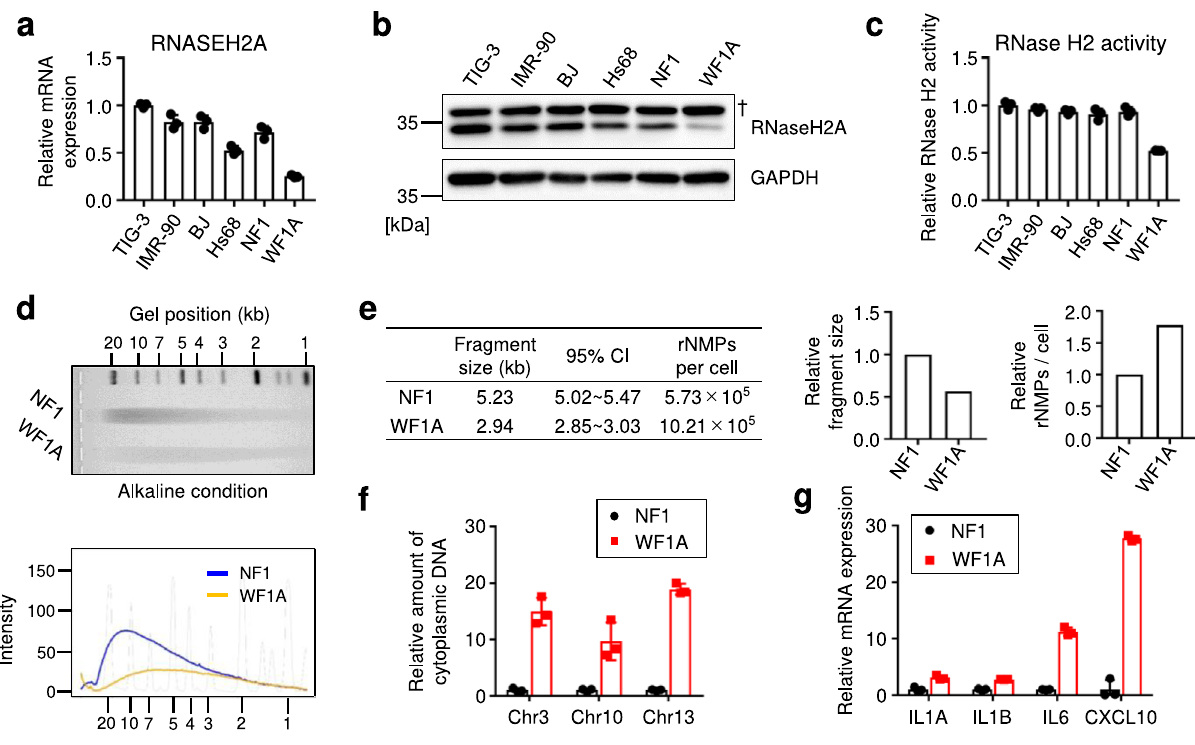
Fig. 6 RNaseH2A dysfunction also occurs in cells derived from patients with Werner syndrome. a RT-qPCR analysis of RNASEH2A mRNA expression in TIG-3, IMR-90, BJ, Hs68, NF1 and WF1A cells (35-40 population doublings). NF1: healthy human fi broblasts, WF1A: fi broblasts derived from patients with Werner Syndrome (WS). Error bars indicate the mean ± SD of technical triplicates. b Western blot of six human fi broblasts as in a using antibodies shown at right. Alpha-tubulin was used as a loading control. † : Nonspeci fi c signal. c In vitro RNase H2-speci fi c activity assay of six human fi broblasts as in a . Error bars indicate the mean ± SD of technical triplicates. d Top: Genomic DNA was extracted from NF1 or WF1A cells and then subjected to alkaline gel electrophoresis following alkaline hydrolysis. The representative gel is shown from three biological replicates. Bottom: The density curves of the gel image are shown. e The estimated fragment sizes and numbers of rNMPs in the NF1 and WF1A cells. f Quantitative PCR analysis of chromosomal DNA in the cytoplasm from the NF1 and WF1A cells using primers against chromosomes 3, 10 and 13. Error bars indicate the mean ± SD of technical triplicates. g RT- qPCR analysis of the indicated genes was conducted using RNA extracted from the NF1 and WF1A cells. Error bars indicate the mean ± SD of technical triplicates. All data are representative of at least three biological Plasmids . The epitope-tagged cDNAs of RNaseH2A were cloned into the pMarX- puro retroviral vector. To amplify fl ag-tagged RNaseH2A cDNA, the following primers were used: 5 ′ -ACCGGATCCACCGCCATGGATCTCAGCGAGCTGGA- 3 ′ (forward) and 5 ′ -ACCGAATTCGAGGCTGGTTGCTGACTCC-3 ′ (reverse). All cDNAs were sequenced using Genetic Analyzer 3130 (Applied Biosystems) and a BigDye Terminator v3.1 Cycle Sequencing Kit (Applied Biosystems). Isolation of cytoplasmic DNA fractions . Cytoplasmic DNA was prepared by modifying a previously described method 16,58 . Brie fl y, cells were centrifuged for 1min in a microcentrifuge, resuspended in 0.3 M sucrose buffer and homogenised by pipetting. The homogenate was overlaid with the same amount of 1.5M sucrose buffer and centrifuged at 18,506 × g for 10min. Cytoplasmic DNA was puri fi ed by treatment with 0.4mg ml − 1 proteinase K (Wako, 160-22752), phenol – chloroform extraction, and ethanol precipitation with a carrier (Dr. GenTLE ® Precipitation Carrier, TaKaRa Bio Inc., 9094). The amount of nuclear DNA was measured via real-time PCR using three different sets of primers designed for different chro- mosomes (human chromosomes 3, 10 and 13). The fragment length of cytoplasmic DNA was de fi ned using an NGS 3K Reagent Kit and a LabChip GX Touch nucleic acid analyser (PerkinElmer). Immuno fl uorescence microscopy . The cells were fi xed with 4% paraformaldehyde/ PBS (Wako, 163-20145) and permeated with 0.5% Triton X-100/Tris-buffered saline for 1min. The cells were blocked with 1% bovine serum albumin (BSA; Sigma-Aldrich, A3059) and 10% goat serum (Sigma-Aldrich, G9023)/ Tris-buffered saline for 1h at 4°C. The samples were then incubated with primary antibodies targeting γ -H2AX (1:1000, Millipore, 05-636) and phospho-(Ser/Thr) ATM/ATR substrate (1:500, Cell Signaling Technology, 2851). After incubation with secondary antibodies coupled to Alexa Fluor 488 or Alexa Fluor 594 (Thermo Fisher Scienti fi c), the nucleus was stained with DAPI (Dojindo, 342-07431). After immunostaining, DNA damage-positive cells were quanti fi ed using a fl uorescence microscope (Carl Zeiss).